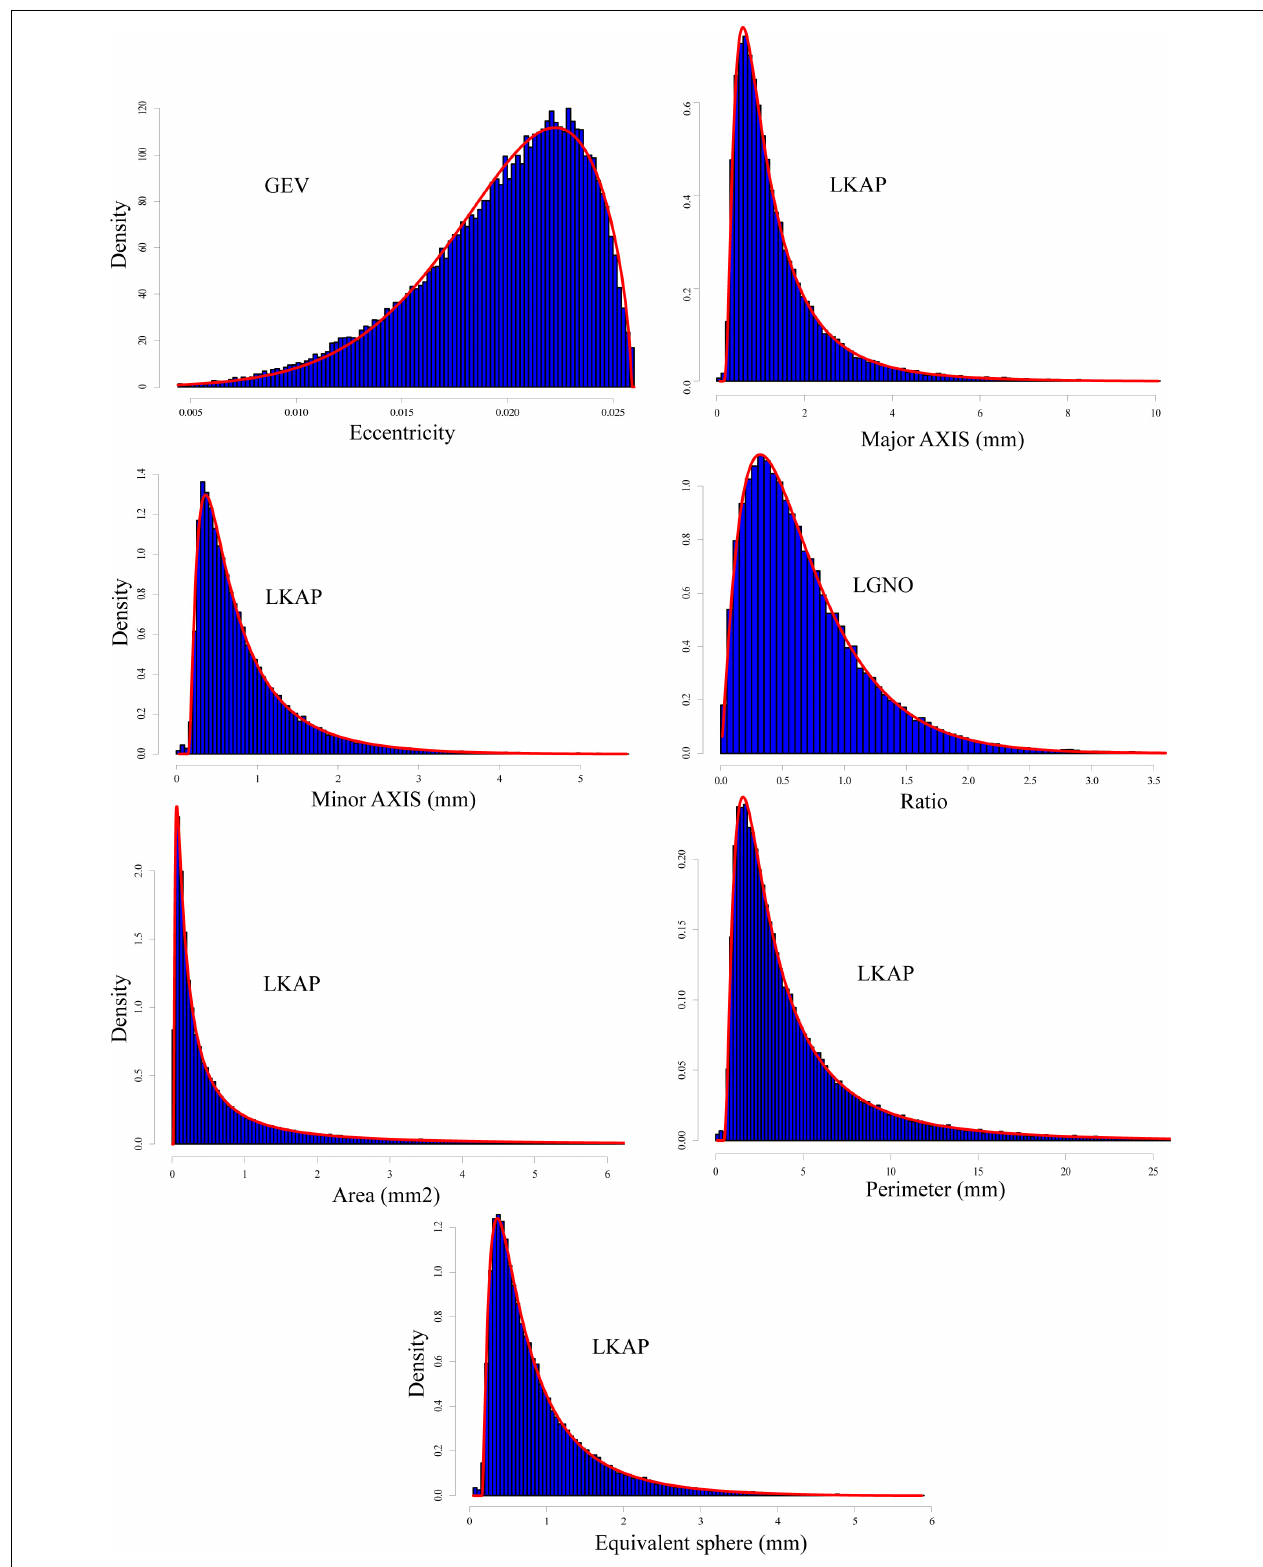
FIGURE 5 | Same as Figure 3 but for all snow grains classified as “facetted” with a total of 50,190 grains.